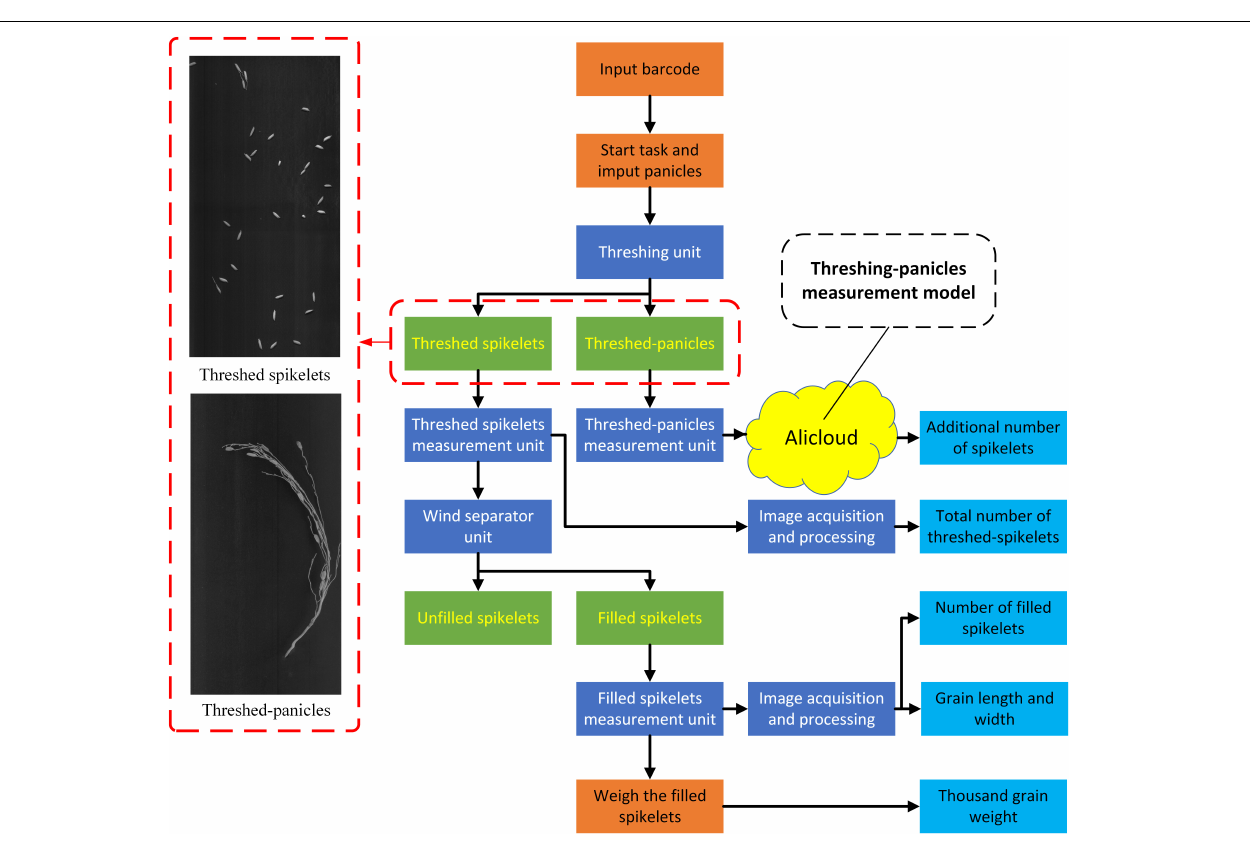
FIGURE 2 | System workflow for yield related trait